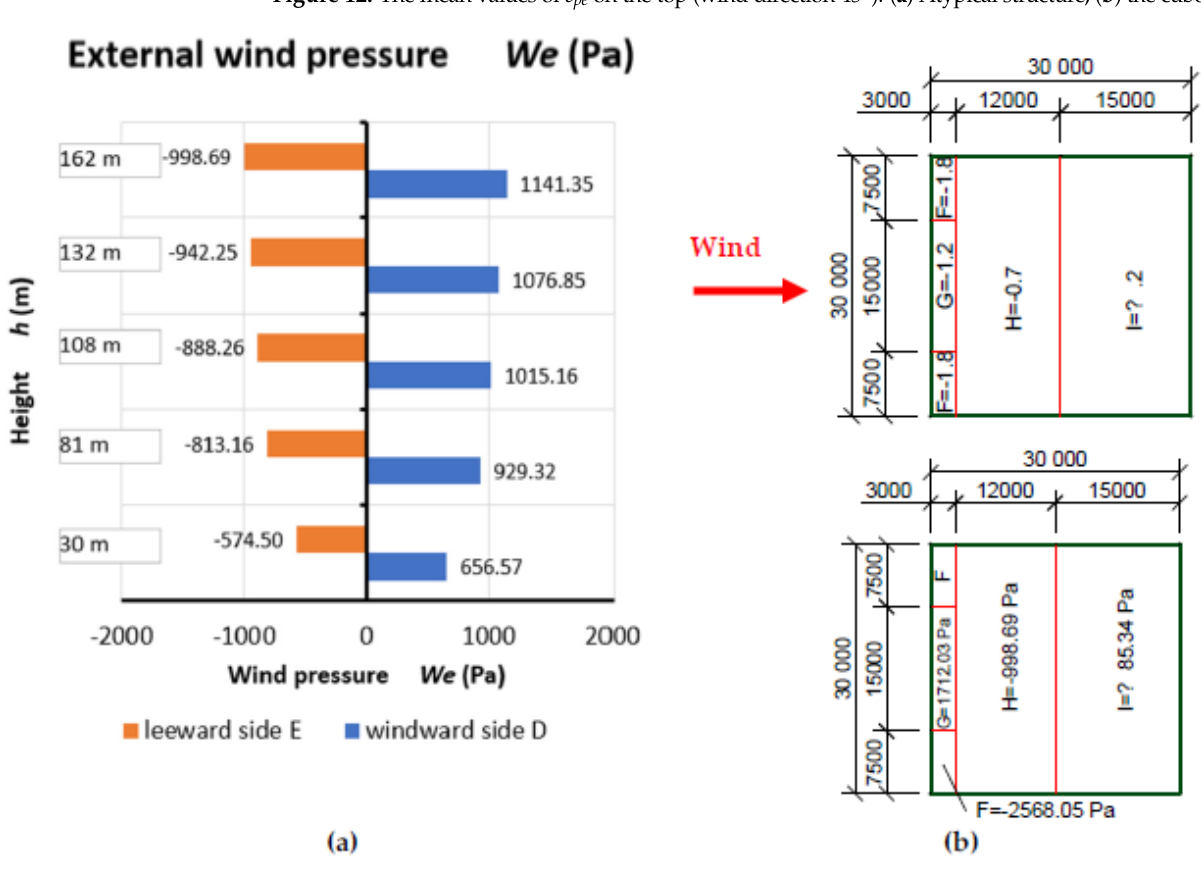
Figure 13. Eurocode (wind direction 45 ◦ ). ( a ) Real wind pressures on leeward side and windward side; ( b ) the roof (up— c pe , down—real pressures).